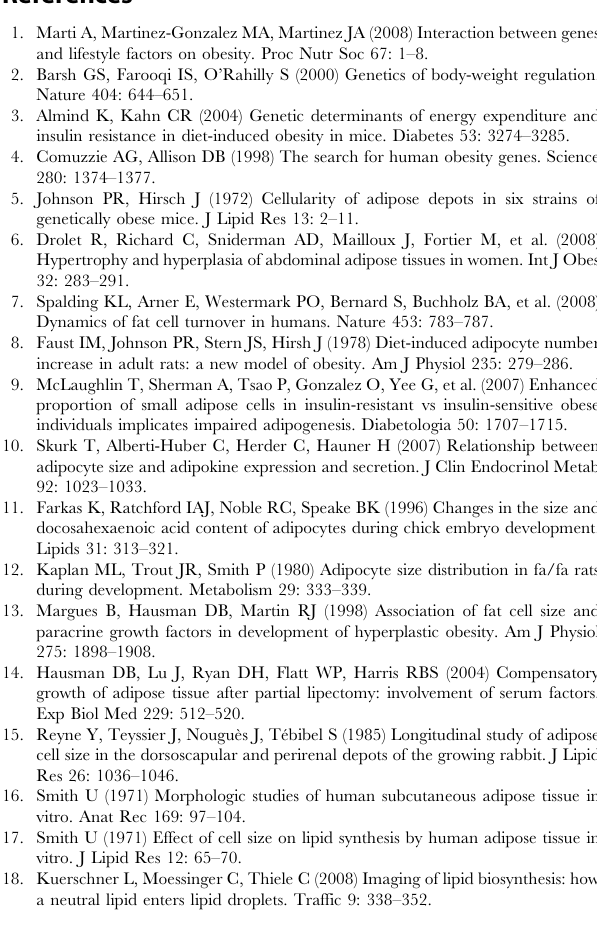
Figure S1 Changes in epididymal (A, B), inguinal (C, D), and brown (E, F) fat pad mass of FVB (A, C, E) and C57 (B, D, F) mice under chow and high-fat diet conditions. X-axes indicate weeks of controlled feeding initiated at the age of 5 weeks old. Y-axes in panel (A–D) shows combined weight of right and left fat pads. Each time point has four sample per group with exception of week 12 (eight samples per group) and 4 week C57 HFD (three samples per group). Lines are drawn for guide. Found at: doi:10.1371/journal.pcbi.1000324.s001 (0.09 MB TIF) Figure S2 Changes in epididymal fat pad of FVB and C57 mice under chow and high-fat diet. (A) and (B) Volume-weighted mean cell size. (C) and (D) Total cell number. X-axes indicate weeks of controlled feeding initiated at the age of 5 weeks old. Each time point has four samples at the time point, four weeks (three available samples). Lines are drawn for guide. Found at: doi:10.1371/journal.pcbi.1000324.s002 (0.07 MB